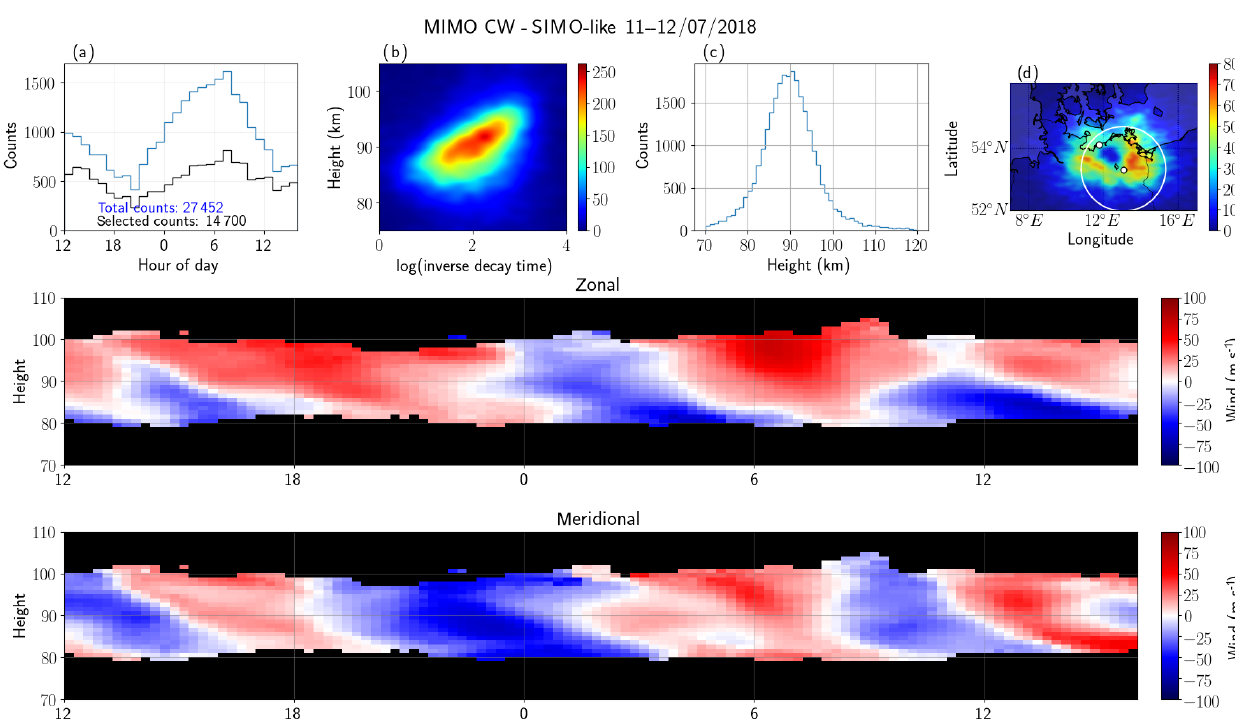
Figure 7. Similar to Fig. 4 but for the MIMO-CW system, applying a SIMO-like analysis.